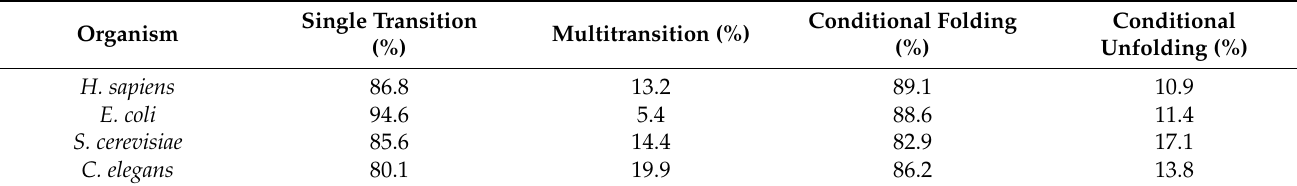
Table 2. Nature of the pH-dependent transitions in the proteomes of four different model organisms. In most of the cases, proteins undergo a single conformational transition towards a more ordered state (conditional folding). Some proteins might switch their conformation more than once along the pH range